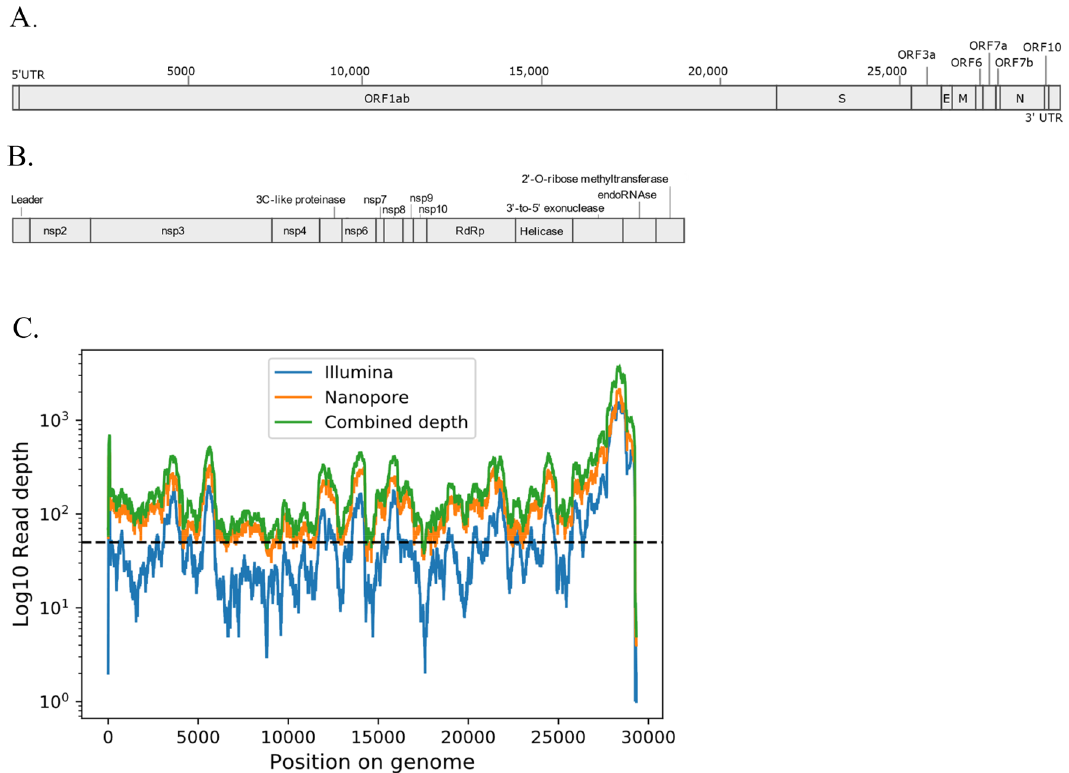
Figure 1. The genomic structure of RhGB01 within the ( A ) entire genome, and ( B ) non-structural proteins. ( C ) Read depth across the genome of RhGB01. Read depth is shown per base across the entire genome from the alignment of Illumina (blue), Nanopore (orange) and combined raw reads (green). The lengths of the genomic features in RhGB01 are 5 ′ UTR (279 bp), ORF1ab (21 kb), S (3.7 kb), ORF3a (813 bp), E (231 bp), M (669 bp), ORF6 (189 bp), ORF7ab (465 bp), N (1.2 kb), ORF10 (78 bp). Total genome length is 29,324